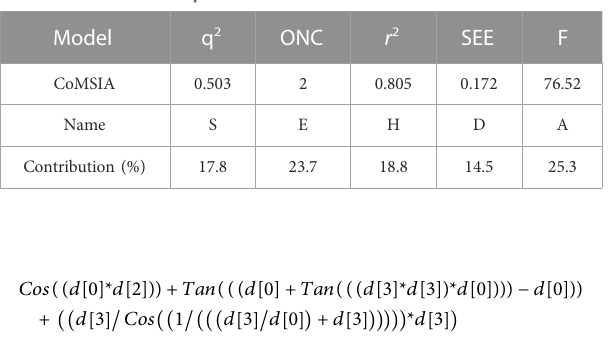
TABLE 5 Details of the optimal CoMSIA model.